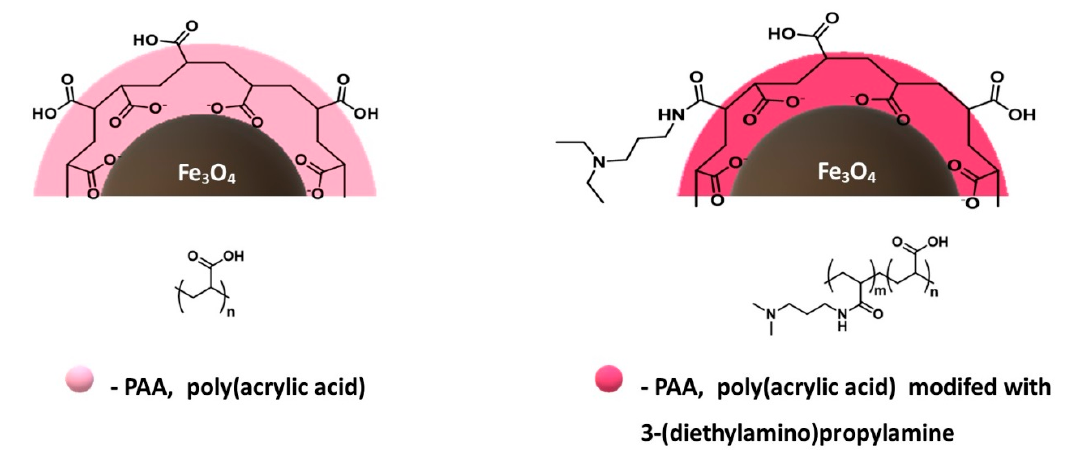
Figure 13. Magnetite nanoparticles coated with polyacrylic acid (PAA) and 3-(diethylamino)propylamine-modified PAA.